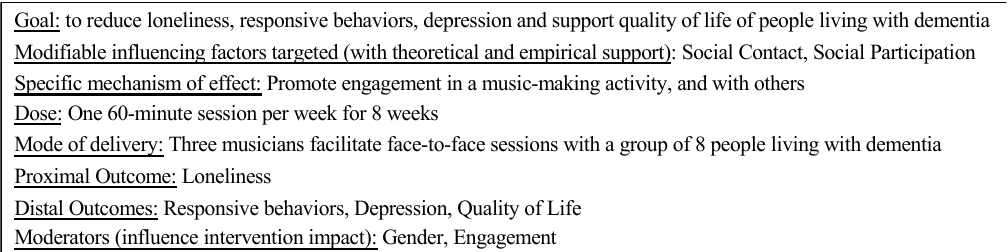
Figure 1. Summary of the Music Connects Us intervention theory including its goals, components, activities, mode of delivery and dose.